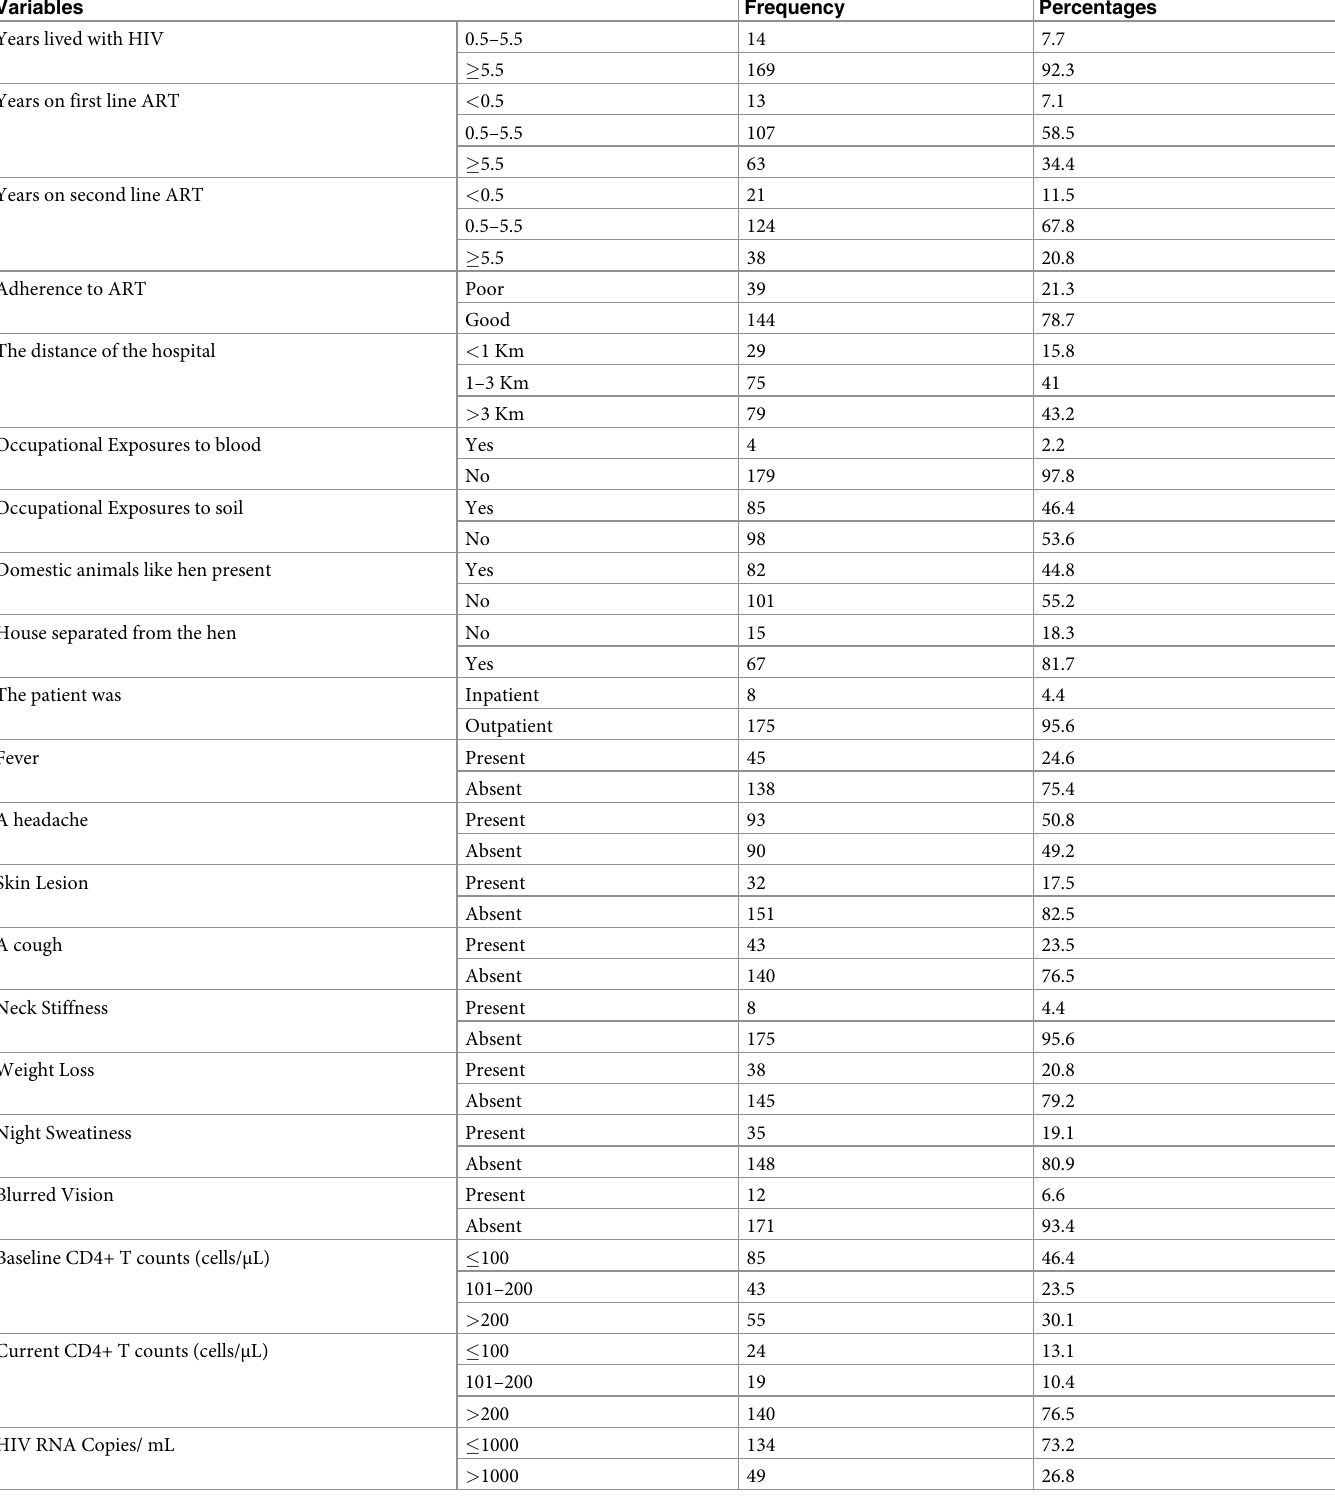
Table 2. Clinical characteristics of HIV-infected patients attending Second-Line ART at Ambo General Hospital and Nekemte Referral Hospital; Western Oromia, Ethiopia; from Sep. 1, 2017, to Nov. 30,